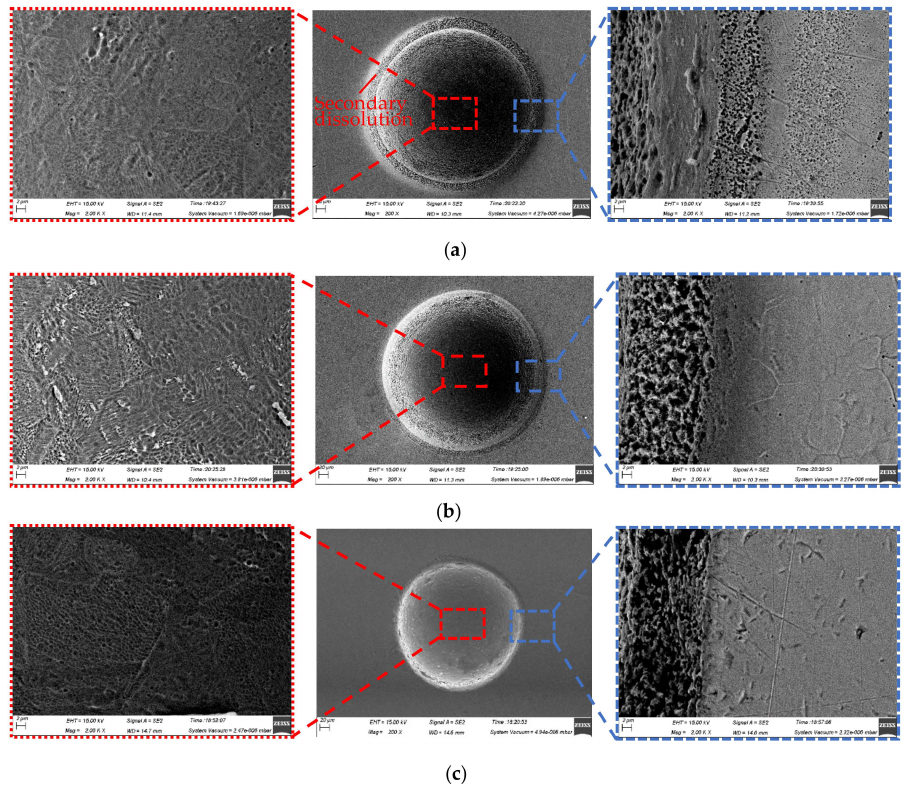
Figure 9. SEM images of the micro-dimples machined with di ff erent modes when the electrical voltage was 20 V, the nozzle’s inner diameter was 170 µ m, and the working gap was 100 µ m. ( a ) Vertically downstream mode; ( b ) vertically upstream mode; ( c ) horizontal mode.